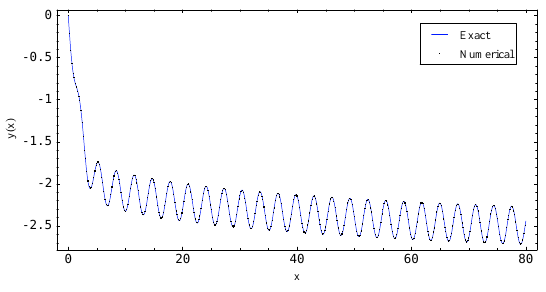
Fig. 9: Comparison of y ( x ) with h = 1 , N = 10 for α = 2 and β = 1 for Example